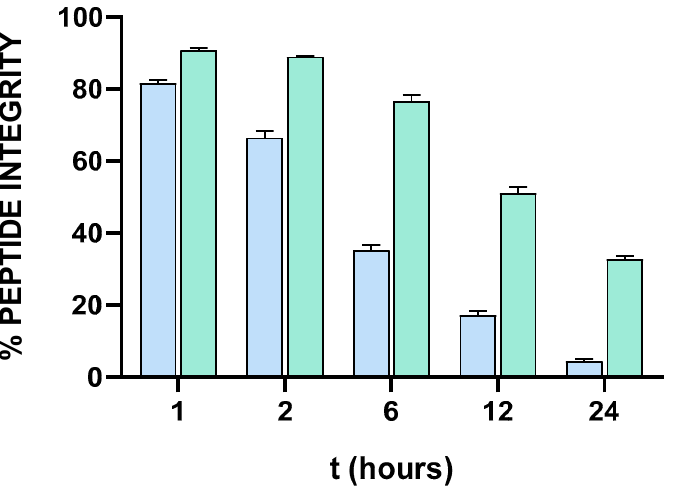
Figure 8. Time-course of the incubation of tripeptides in human serum.